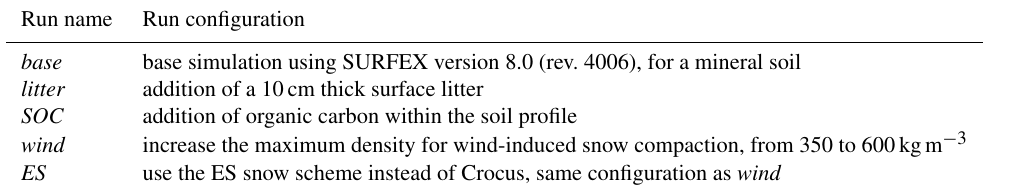
Table 1. Configurations of the numerical experiments, all realized with Crocus except for ES . Changes are incremented in addition to the previous